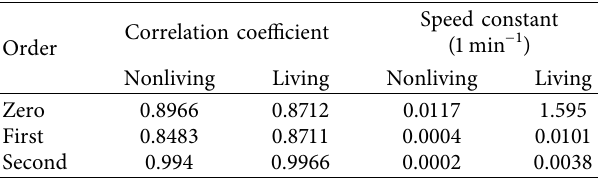
Table 4: Correlation coefcient values of adsorption velocity equations in the nonliving and living